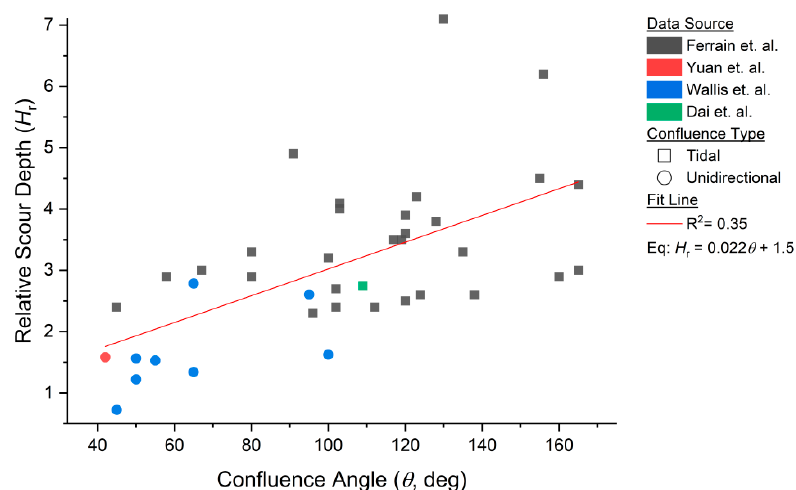
Figure 9. Relationship between H r and θ . The data source is from studies carried out by Ferrarin et al. [21] , Yuan et al. [6] , Wallis et al. [61] , and Dai et al. [28] .